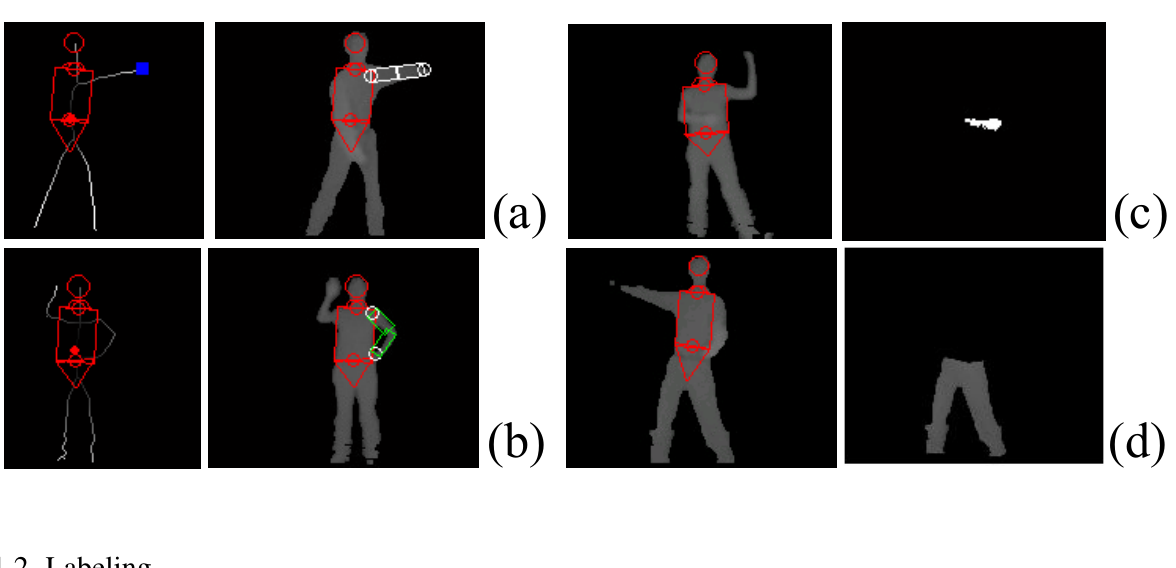
Figure 6. HNT template localization (shown in red) and limb detection: (a) Open arm detection; (b) Looped arm detection; (c) Arm detection that is in front of torso; (d) Lower limb